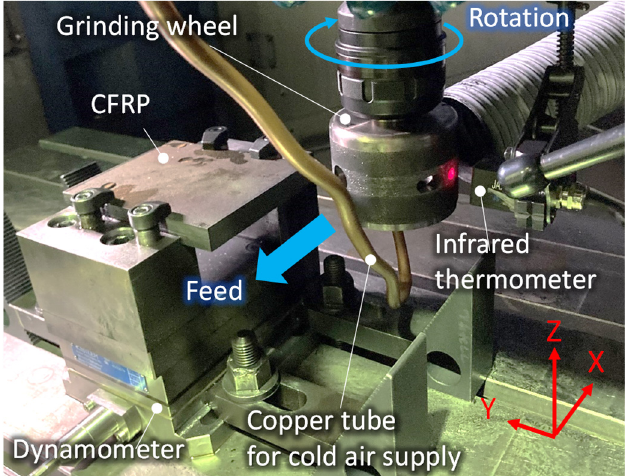
Figure 7. Experimental setup. Table 4. Grinding conditions.